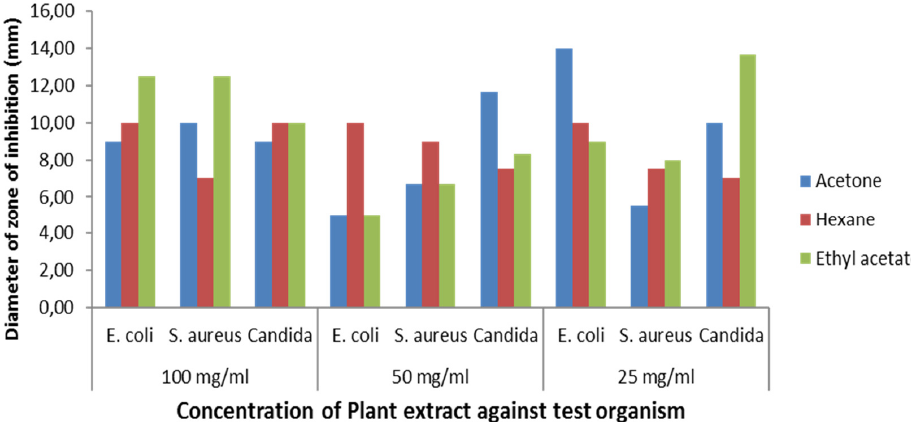
Figure 2. Average zones of inhibition of different concentrations of A. indica leaves against the tested microorganisms